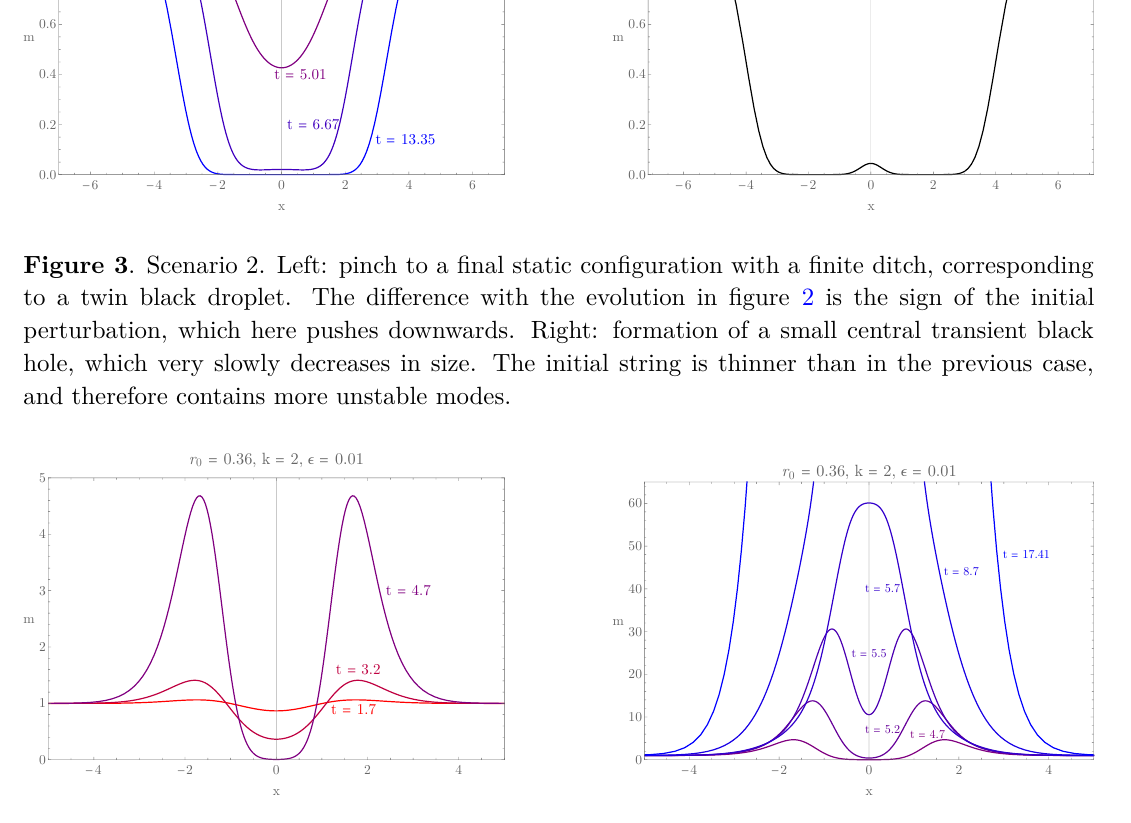
Figure 4 . Scenario 3. Left: initial formation of a pinch. Right: subsequent evolution, zoomed out in the vertical axis to show the unbounded growth after the arrival of the black tsunami. The initial perturbation is a higher mode than in the previous figures, and manages to trigger both the pinch and the